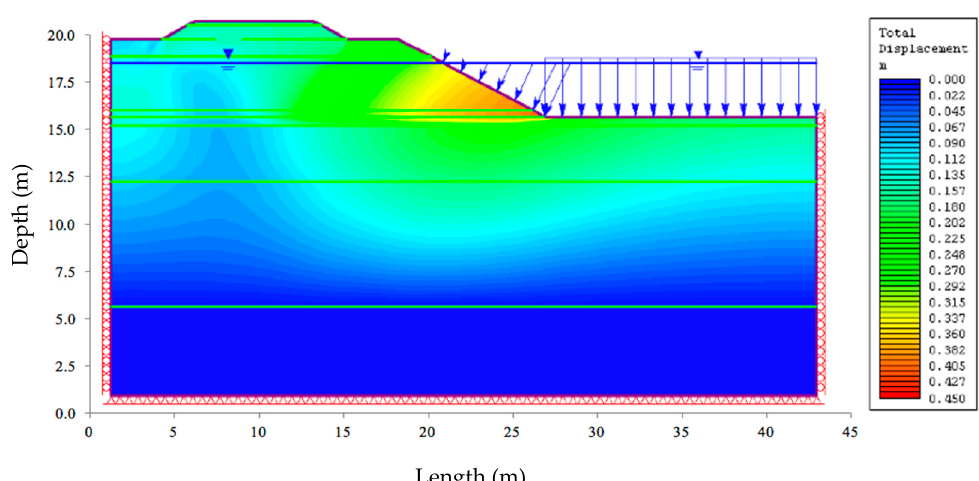
Figure 13. Colored contour shading of the total displacement (base case).